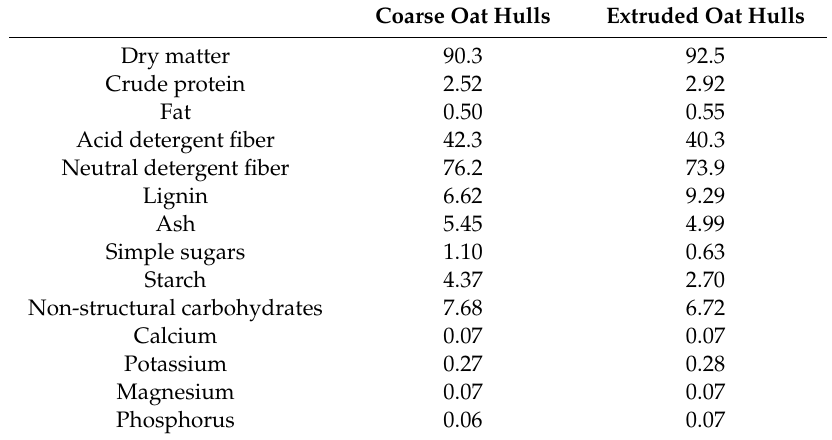
Table 1. Analyzed composition of the oat hulls used in the experiment (% as fed basis).